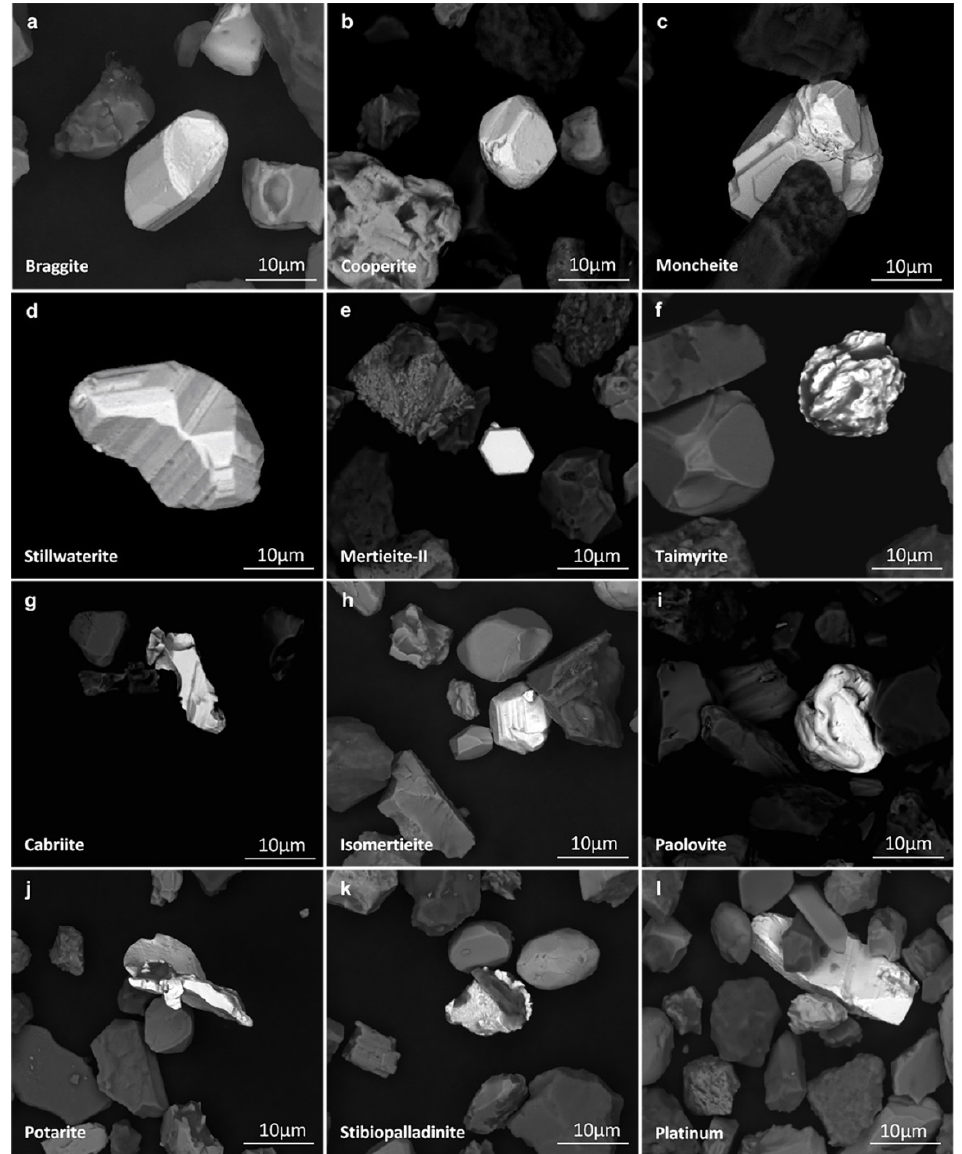
Figure 6. A selection of backscatter electron (BSE) images of platinum-group minerals identified in the till samples. ( a ) Braggite ((Pt,Pd,Ni)S); ( b ) Cooperite (PtS); ( c ) Moncheite ((Pt,Pd)(Te,Bi) 2 ); ( d ) Stillwaterite (Pd 8 As 3 ); ( e ) Mertieite-II (Pd 8 (Sb,As) 3 ); ( f ) Taimyrite ((Pd,Cu,Pt) 3 Sn); ( g ) Cabriite (Pd 2 SnCu); ( h ) Isomertieite (Pd 11 Sb 2 As 2 ); ( i ) Paolovite (Pd 2 Sn); ( j ) Potarite (PdHg); ( k ) Stibiopalladinite (Pd 5 Sb 2 ); ( l ) Platinum (Pt).